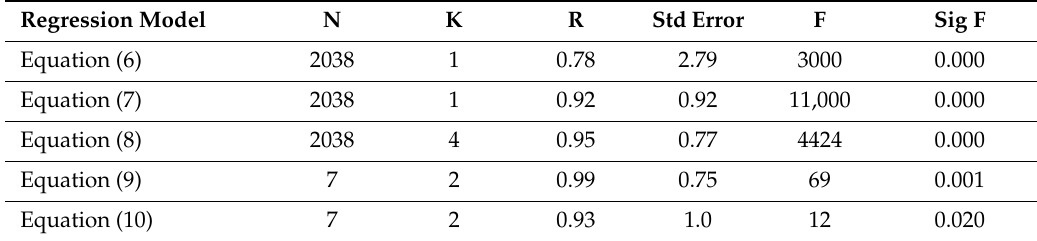
Table A1. Summary of modulus regression statistics. N is the number of observations. K is the number of variables in the model. Units of standard error (Std Error) are GPa. Ris the correlation coe ffi cient between observations and predictions. Std Error is given by Equation (A2). F is the Fisher coe ffi cient and sig F is the significance of the